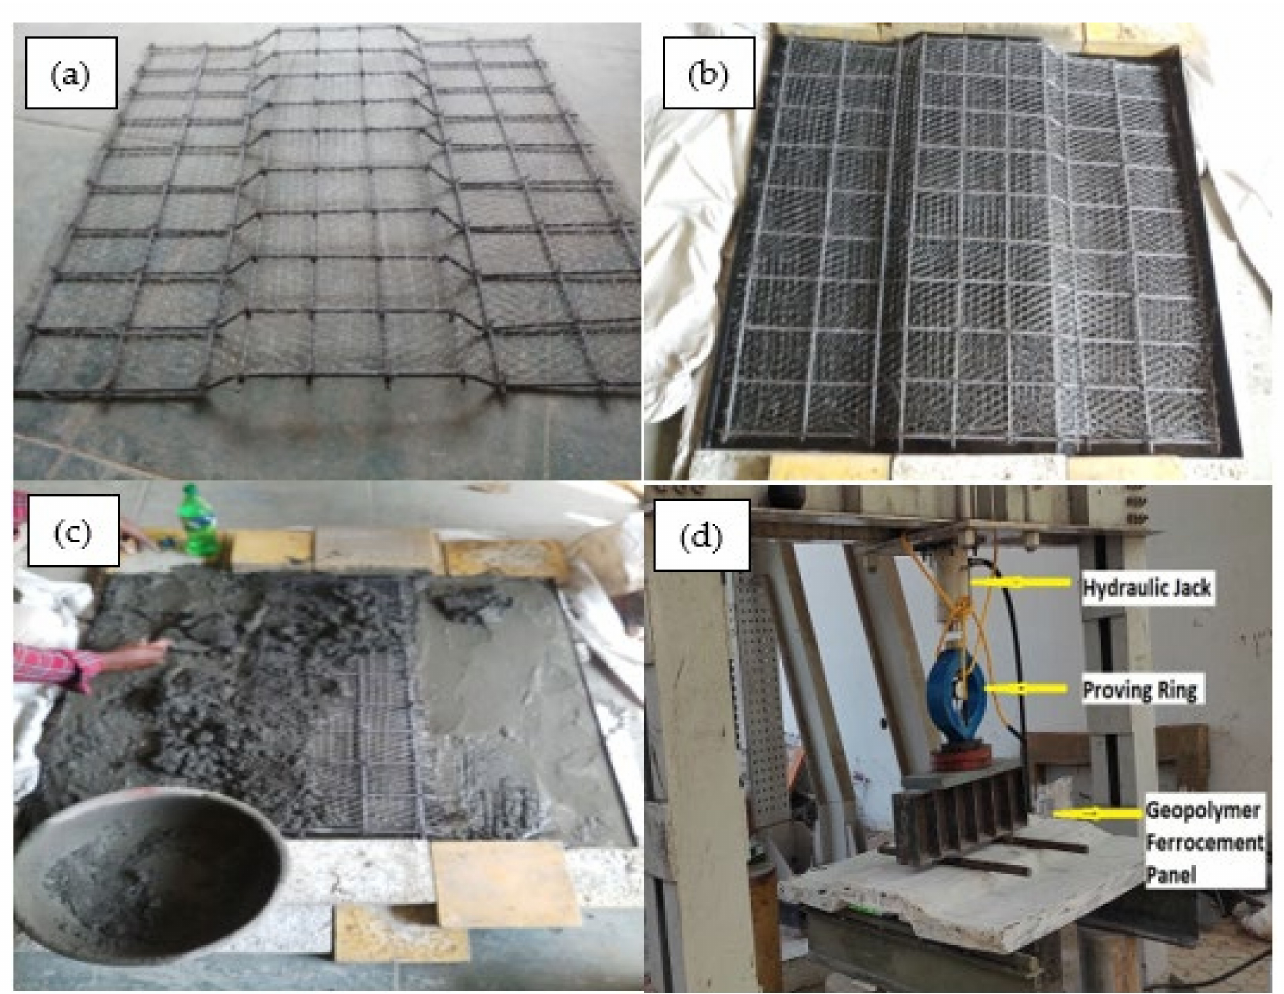
Figure 5. ( a ) Skeletal steel with mesh layers, ( b ) Arrangement on mould, ( c ) Casting of panel, and ( d ) Test setup of